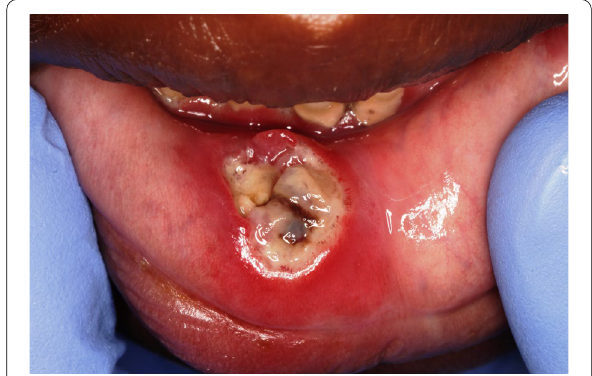
Fig. 1 Necrotising gingivitis adult HIV-seropositive subject: gingival marginal necrosis and truncation of interdental papillae